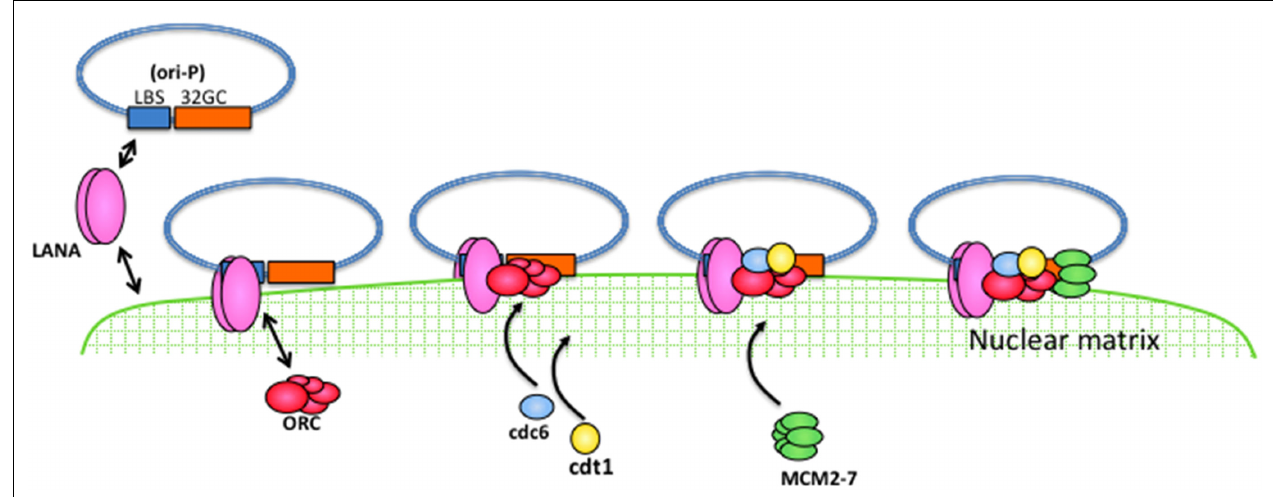
FIGURE 3 |A model for latent DNA replication of KSHV. LANA can associate with the nuclear matrix and can directly bind to the ori-P so that LANA can recruit the ori-P to the nuclear matrix. Cellular DNA replication machinery assembles to the nuclear matrix in a cell cycle-dependent manner, and is therefore available for viral DNA